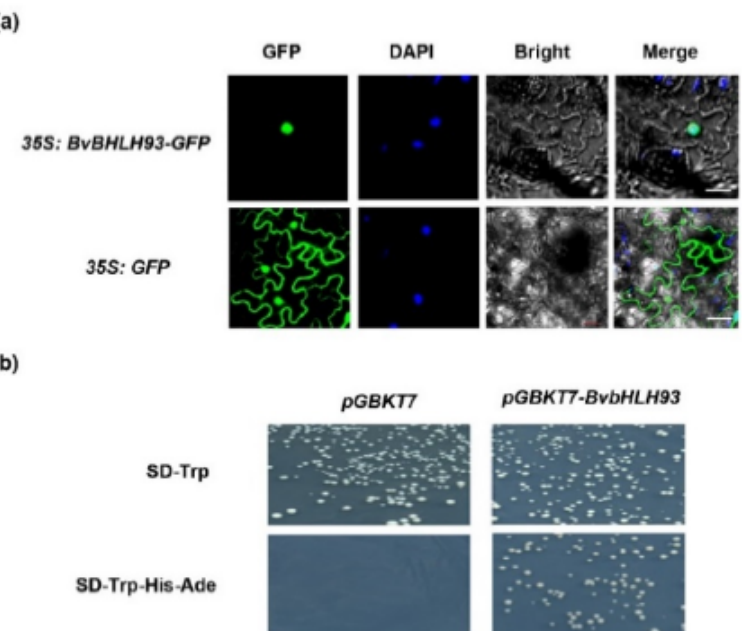
Figure 2. Subcellular localization and activation activity analysis of the BvbHLH93. ( a ) Subcellular localization of BvbHLH93 in Nicotiana tabacum L. (Bar = 50 µ m). ( b ) Activation activity of BvbHLH93. The transformants with pGBKT7 (left) and pGBKT7- BvBHLH9 3 (right) grow normally on SD-Trp medium, and only the transformants pGBKT7- BvBHLH93 (right) can grow normally on SD-Trp-His- Ade